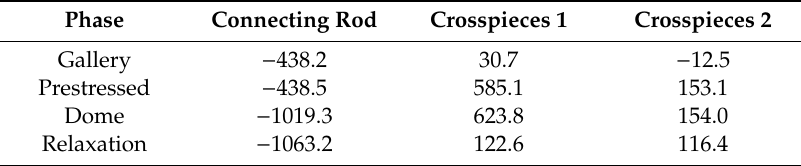
Table 21. Axial forces in connecting rod and crosspieces (kN). Phase Connecting Rod Crosspieces 1